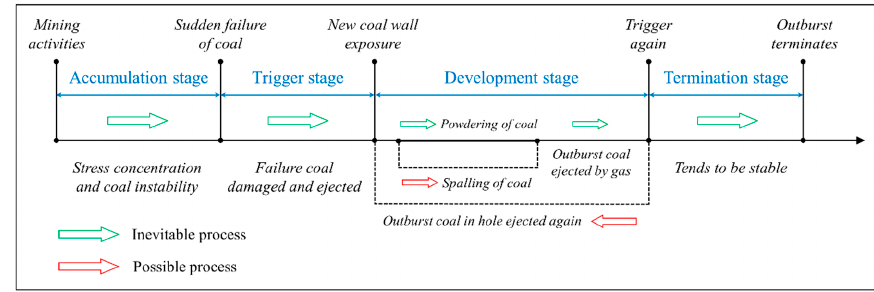
Figure 3. Stages of the outburst process. Sensors 2020 , 20 , x FOR PEER REVIEW Table 1. Stress loading of the outburst at different zones.